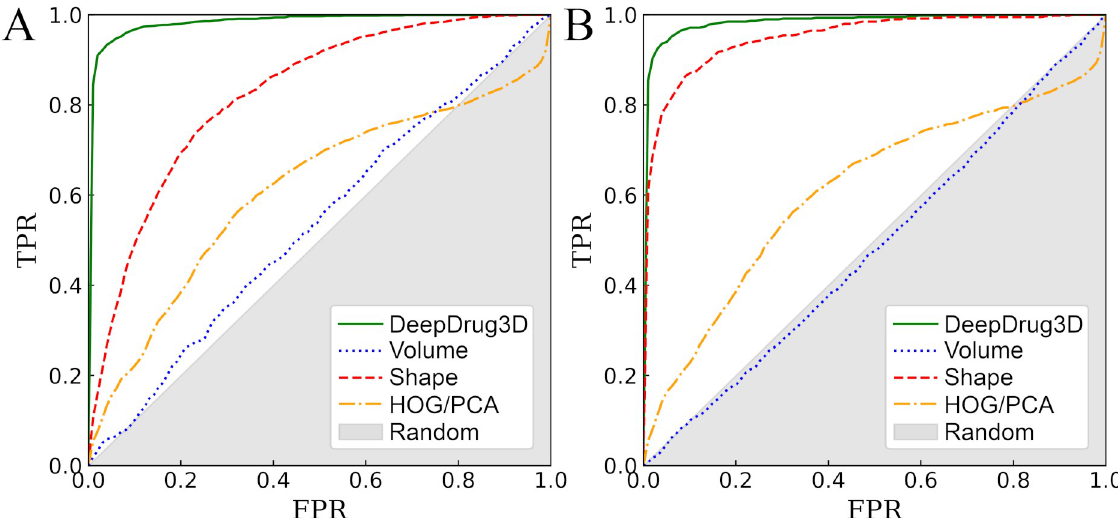
Fig 4. ROC plots evaluating the performance of various algorithms to classify ligand-binding sites. DeepDrug3D is compared to volume- and shape-based approaches, as well as a classifier employing the histogram of gradients with principal component analysis (HOG/PCA) for ( A ) nucleotide- and ( B ) heme-binding pockets. The x -axis shows the false positive rate (FPR) and the y -axis shows the true positive rate (TPR). The gray area represents a random prediction.